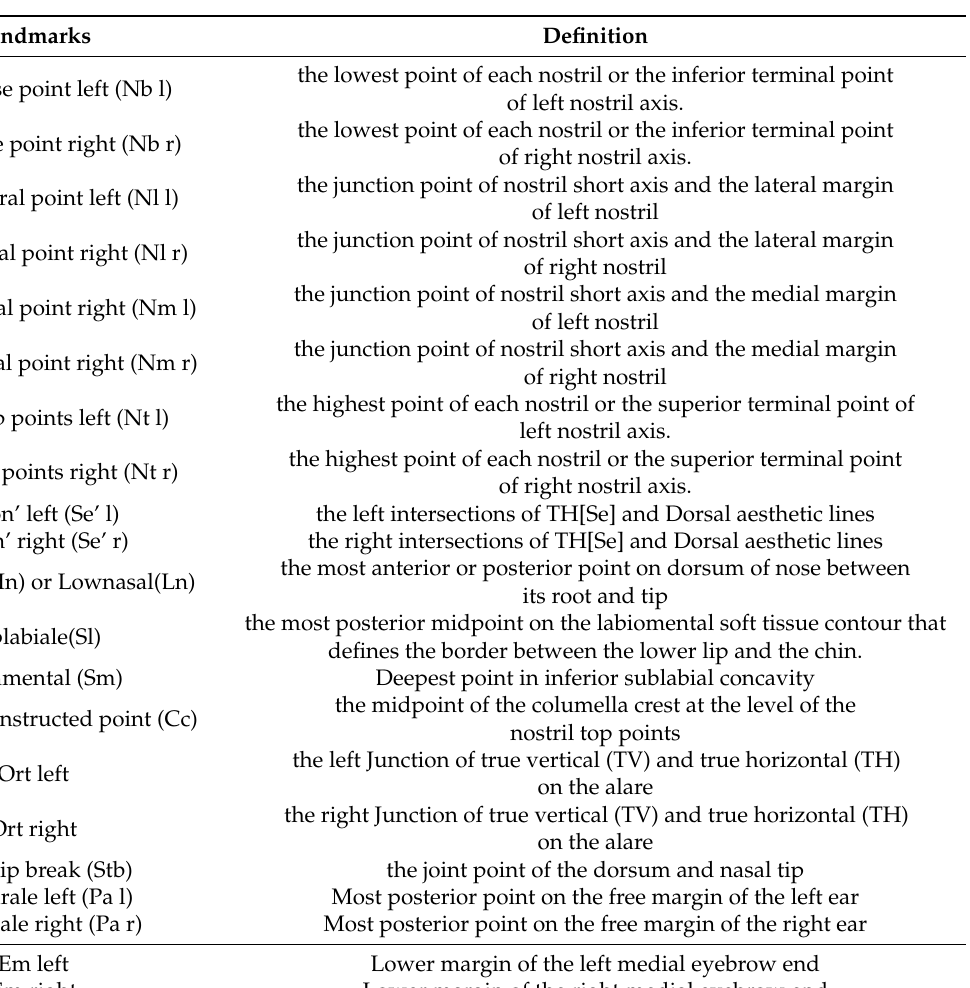
Table 2. The name and definitions of 46 anthropometric nasal landmarks involved in this